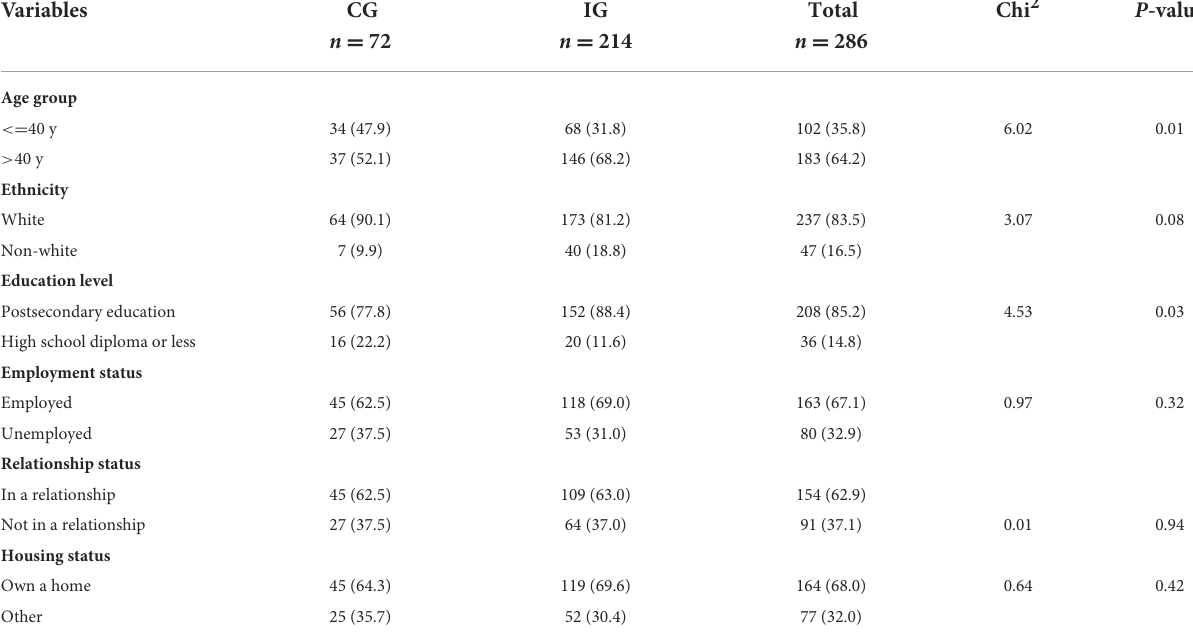
TABLE 1 Distribution of demographic characteristics and isolation conditions of the